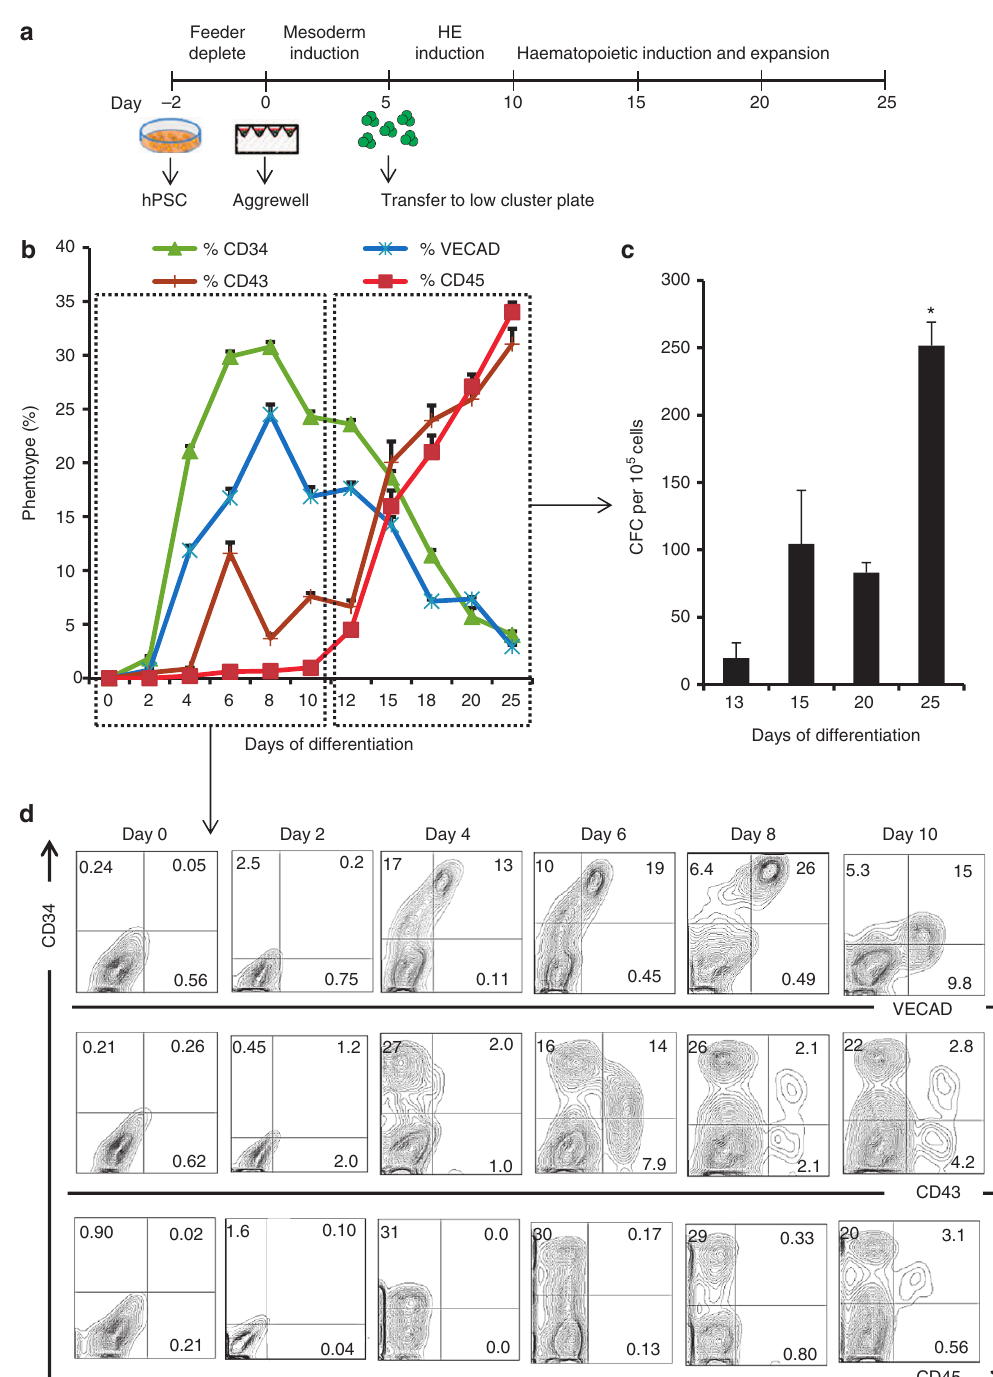
Figure 1 | Characterization of hPSC differentiation to haematopoietic progenitor cells. ( a ) Overview of serum-free differentiation protocol: size-controlled hPSC aggregates are formed in Aggrewell and differentiated for 25 days in serum-free medium. ( b ) Phenotype tracking of blood progenitor cells during differentiation, n ¼ 4. ( c ) Enumeration of CFCs from differentiating day 11–25 hPSCs, n ¼ 3. ( d ) Representative flow cytometry plots from day 0 to 10 depicting CD34, VECAD, CD43 and CD45 expression. Data are presented as mean ± s.e.m. Treatments displaying asterisks are significantly different from other groups ( P r 0.05, one-way ANOVA post hoc Tukey test). See also Supplementary Fig.